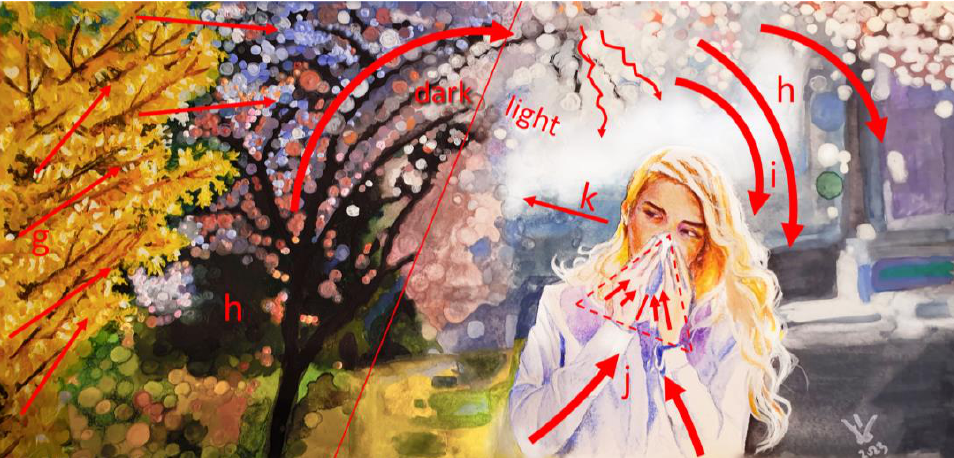
Figure 3. Formal analysis of a frequently used picture in advertisements of allergy-related products and services depicting plants. The picture represents a popular design concept in visual marketing in allergies. Red arrows, lines and shapes are tools of formal analysis, showing how the viewer’s eyes are led by major elements and design principles (underlined in the text below) of the picture to the central figure (patient) and affected organs (mouth and nose). The picture depicts a woman walking on a street, while the pollen of the trees ( Forsythia × intermedia and Prunoidae) are ‘falling onto’ her, provoking an allergic reaction. The composition is unbalanced (weighted against the patient by the higher proportion of the dark area). Action is shown by lines of branches of ‘allergenic’ trees pointing to the patient (g,h), whose allergic reaction is emphasized by movements (j) and shapes (l, delineated by hands raised to the nose or mouth). A negative effect of plants is suggested by colors and values, as well as by lines, according to the direction of the patient’s gaze (k). The current picture (aquarelle painting) is made by the author (Don á t Magyar) to represent the design of the original photograph